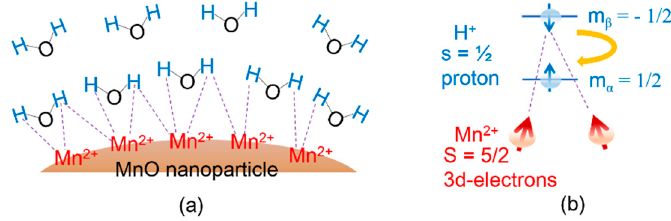
Figure 10. ( a ) Magnetic dipole ‒ dipole interactions between the Mn 2+ (S = 5/2) species on the MnO nanoparticle surface and the water proton spins (s = 1/2), as indicated by the dotted lines. The FA-PAA ligands coating the nanoparticle surface were omitted for simplicity. ( b ) Stimulation of the longitudinal water proton spin relaxation from the β‒ spin (m β = ‒ 1/2) to α‒ spin (m = 1/2) by the 3d-electron spins (S = 5/2) of Mn 2+ (here, two stimulating Mn 2+ species are arbitrarily shown).